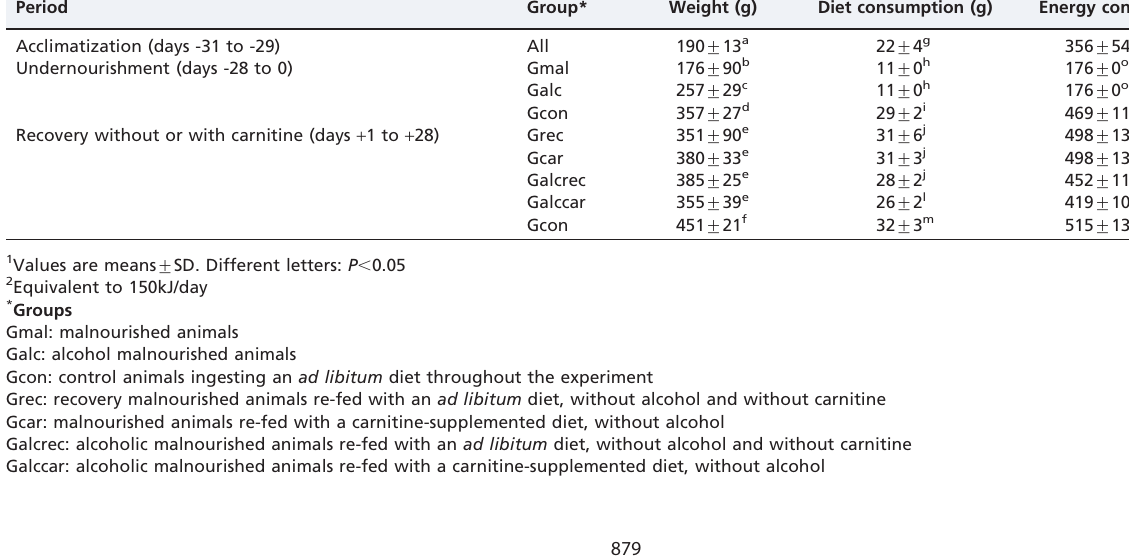
Period Acclimatization (days -31 to